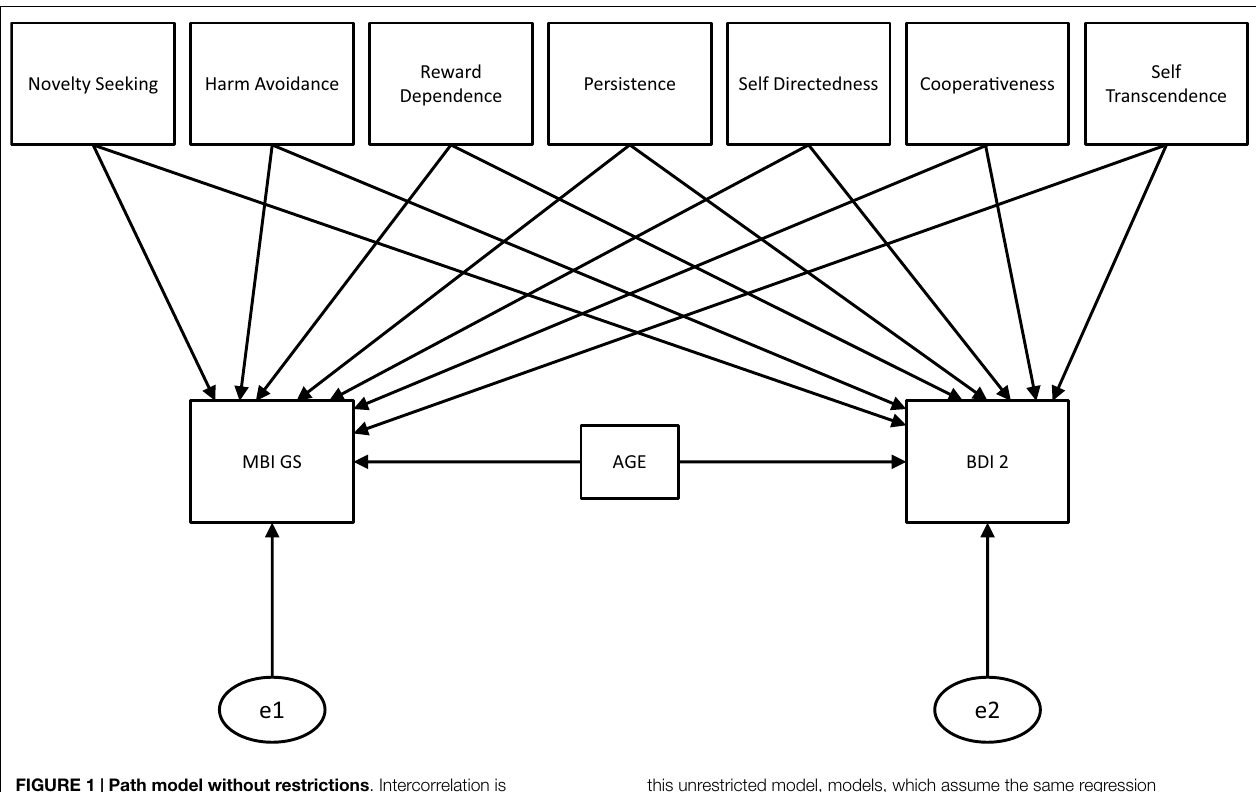
FIGURE 1 | Path model without restrictions . Intercorrelation is expected between all seven dimensions of the TCI. All dimensions and age are used to predict participants values in MBI scores (sum score, and scores for exhaustion, efficacy, and cynicism) and BDI 2 scores. Next to